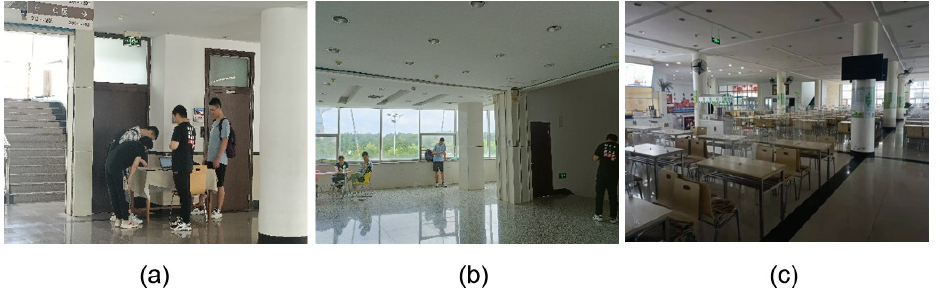
Figure 6. Different experimental scenarios are shown in the figures. ( a ) shows the experimental configuration and data acquisition in the teaching area. ( b ) is data acquisition in the complex building. ( c ) is data acquisition in the school